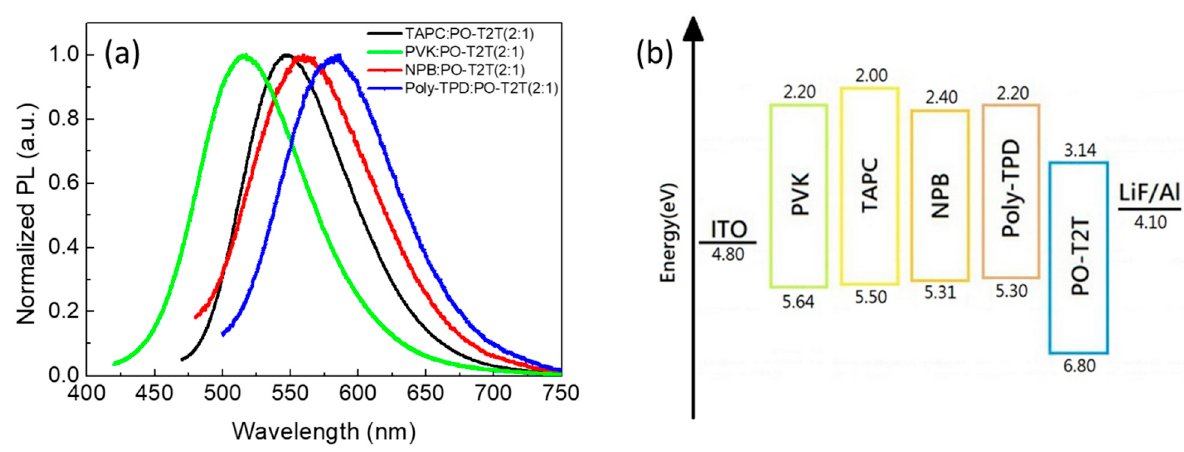
Figure 2. Absorption and photoluminescence (PL) spectra of donors, acceptor, and exciplexes obtained in solid films in air (for PL, λ ex = 330 nm): ( a ) TAPC:POT2T, ( b ) PVK:POT2T, ( c ) NPB:POT2T, and ( d ) Poly-TPD:POT2T.